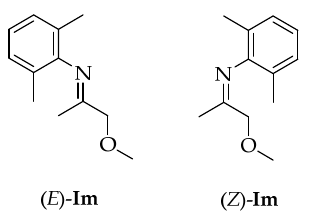
Figure 3. Stereoisomers of Im . E/Z is 86:14 in acetic acid (calculated) and neat (experimental). In acetic acid, Im exists as an equilibrium of E and Z isomers favoring ( E )- Im ,